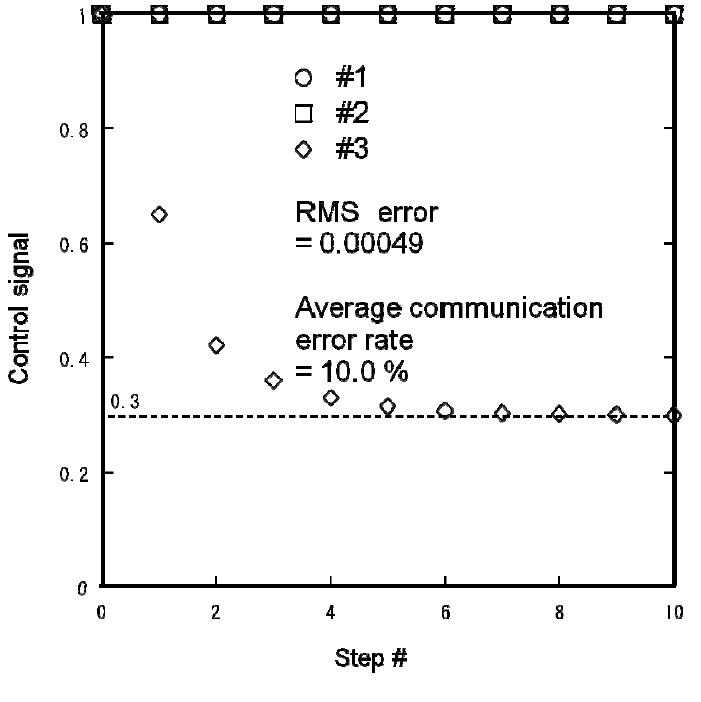
Figure 16. Experimental distributed lighting result obtained using Mote testbed for { s , s , s } = 1 2 3